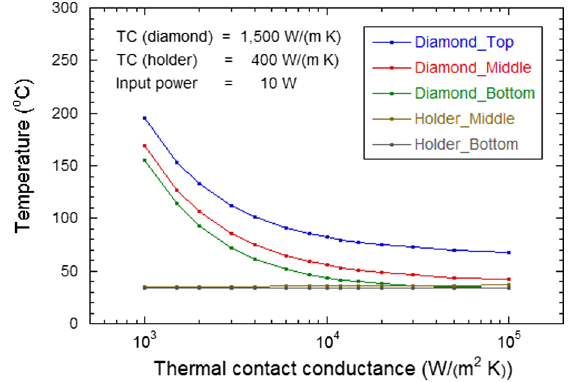
FIG. 11. Temperature variations of the quarter model due to difference in the TCC between diamond and copper.